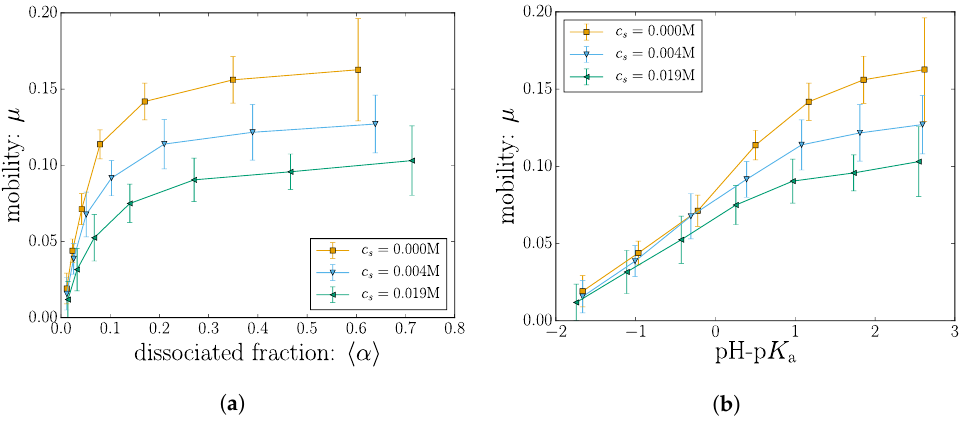
Figure 8. (Color online) The electrophoretic mobility is plotted as a function of ( a ) the dissociated fraction and ( b ) pH-p K a